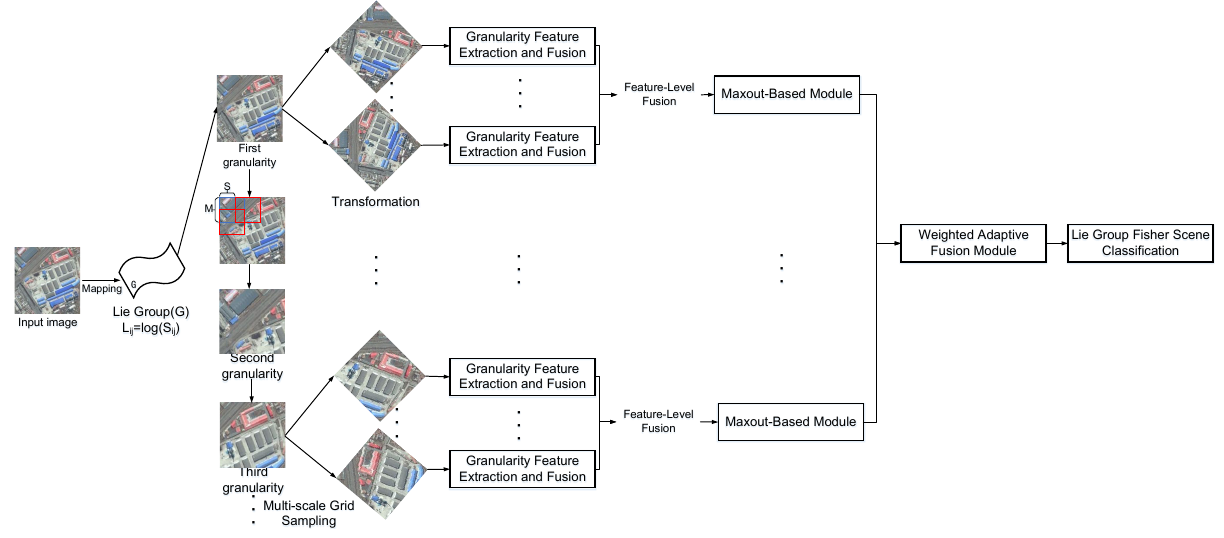
Figure 4. General architecture of our network. The main modules involve Lie Group sample map- ping, granularity extraction and fusion of different transformation under multi-scale grid sampling, construction of Lie Group covariance matrix corresponding to multi-source heterogeneous features based on maxout module, selecting the most distinguished second-order features, the fusion of these most distinguish second-order features, and utilizing Lie Group Fisher for further